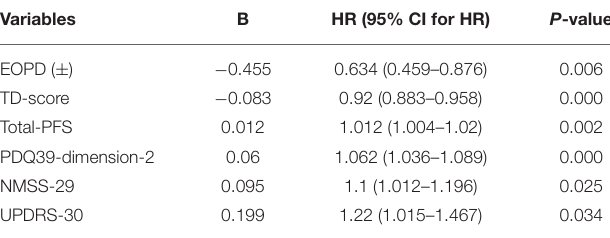
TABLE 4 | Risk factors of FOG selected by multivariate Cox regression. Variables B HR (95% CI for HR) P -value EOPD ( ± ) −